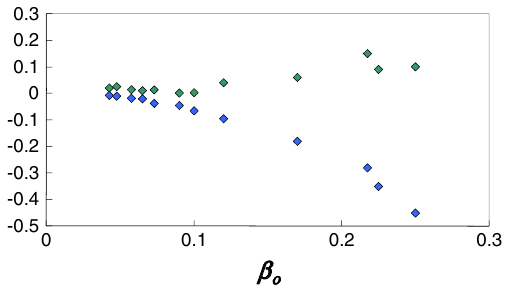
FIG. 12. Average electric fields (normalized to the longitudinal one) vs (cid:1) of the peaks required for steering correction in 12 QWRs, calculated by means of expression (15). Blue diamonds: =E E generated by the tilted drift tube edge; green diamonds: y 1 o zo E =E generated by the tilted beam port edge. At the higher y 2 o zo values of (cid:1) the required transverse electric field amplitude approaches the one of the accelerating